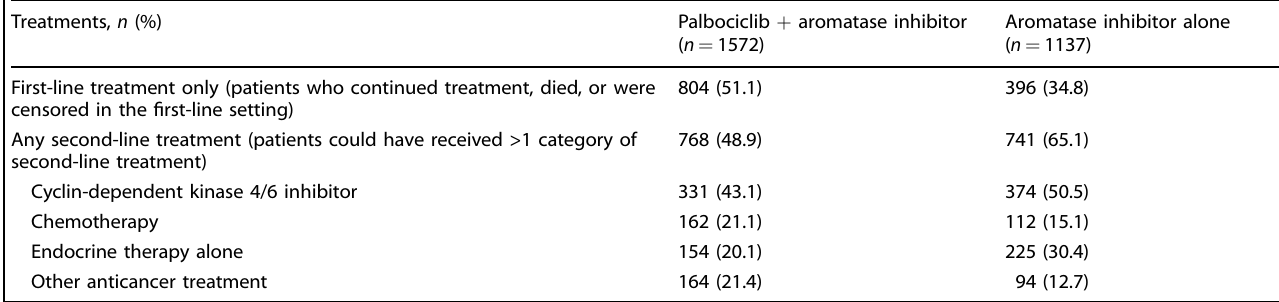
Table 3. Subsequent second-line anticancer treatments after stabilized inverse probability of treatment weighting analysis. Treatments, n